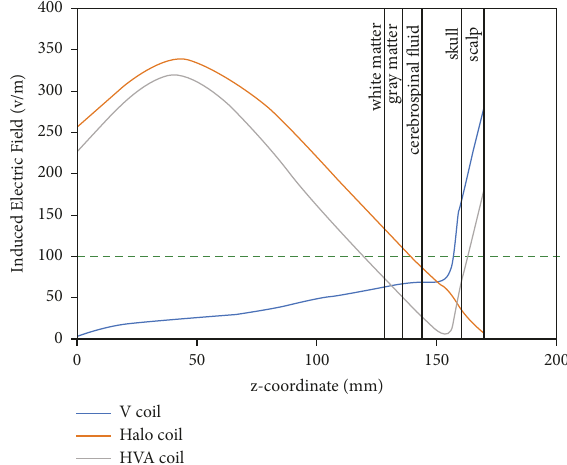
Figure 6: Electric field distribution along test line 2. Green dotted line indicates the neuron stimulation threshold.